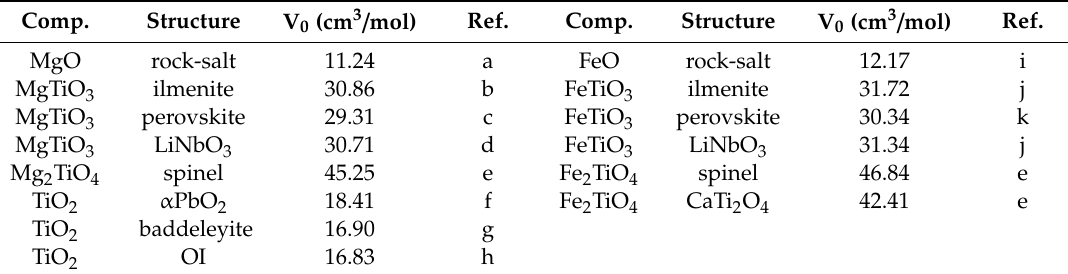
Table 2. Molar volumes of phases in the systems MgO-TiO 2 and FeO-TiO 2 . Comp. Structure V 0 (cm 3 / mol) Ref. Comp. Structure V 0 (cm 3 / mol) Ref.